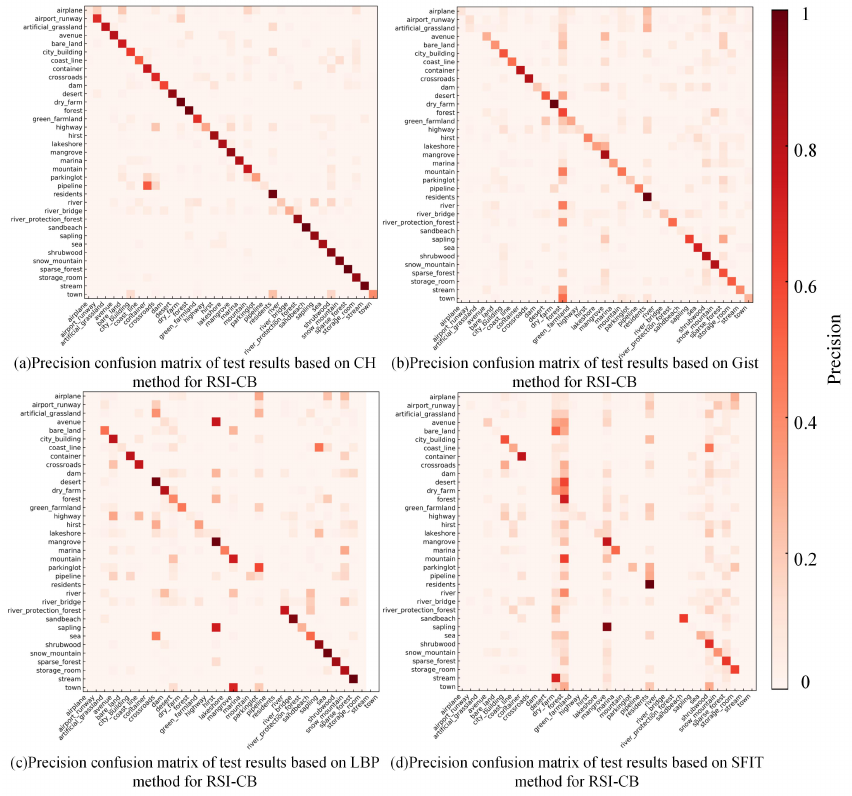
Figure 12. Precision confusion matrix of test results based on handcrafted features for